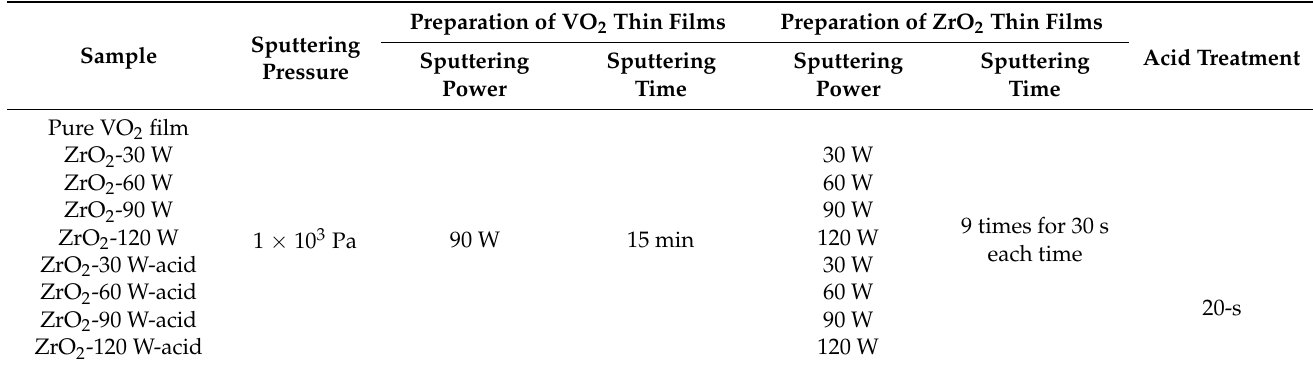
Table 1. Preparatory conditions of pure VO 2 film and ZrO 2 -doped VO 2 film.